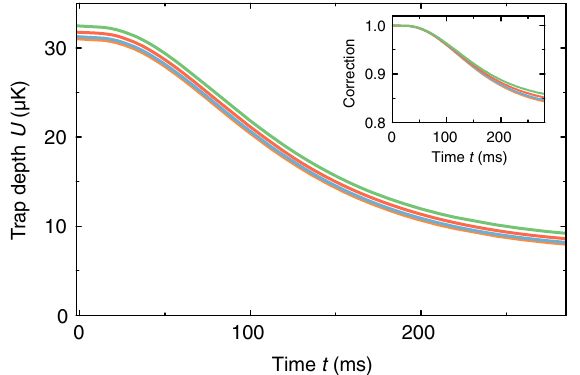
FIG. 7. Potential depth during forced evaporation. The trap depth of the combined potential of far off-resonant optical lattice trap, magnetic field, and probe-induced potential as the magnetic gradient is ramped up from zero to its maximal value. The inset shows the correction factor required to correct g 2 for the shift of the cloud relative to the maximal probe intensity. Different colors correspond to different intracavity photon numbers, with the color code the same as in Fig.